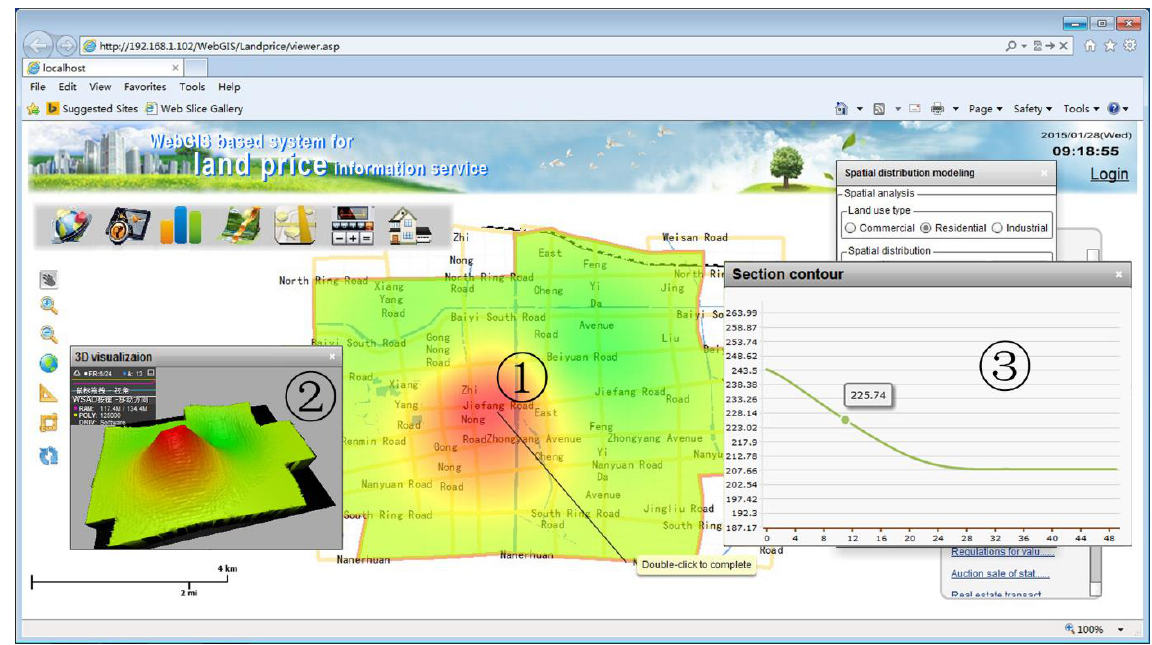
Figure 4. Land price calculation of selected monitoring points.